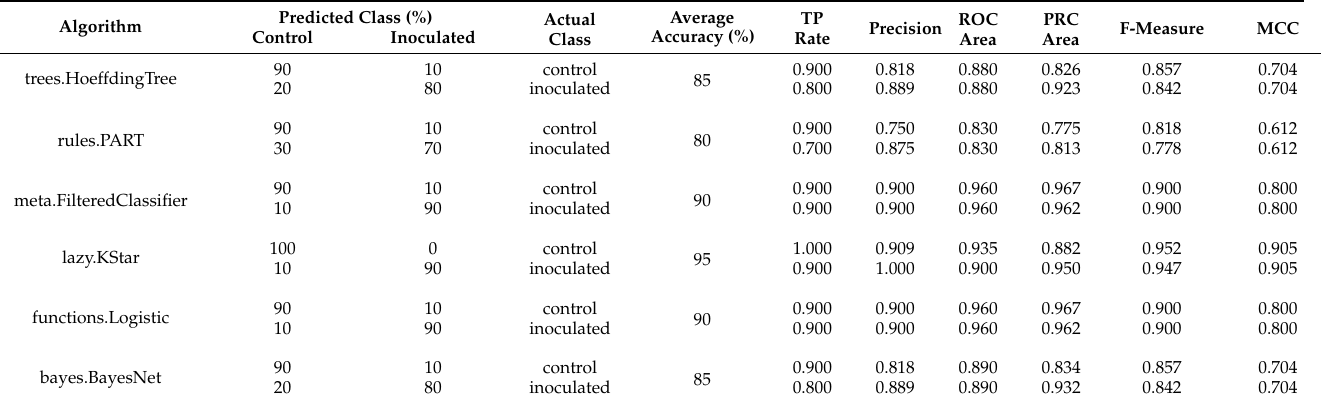
Table 3. The discrimination performance metrics of the control and yeast-inoculated tomato ‘Ideal’